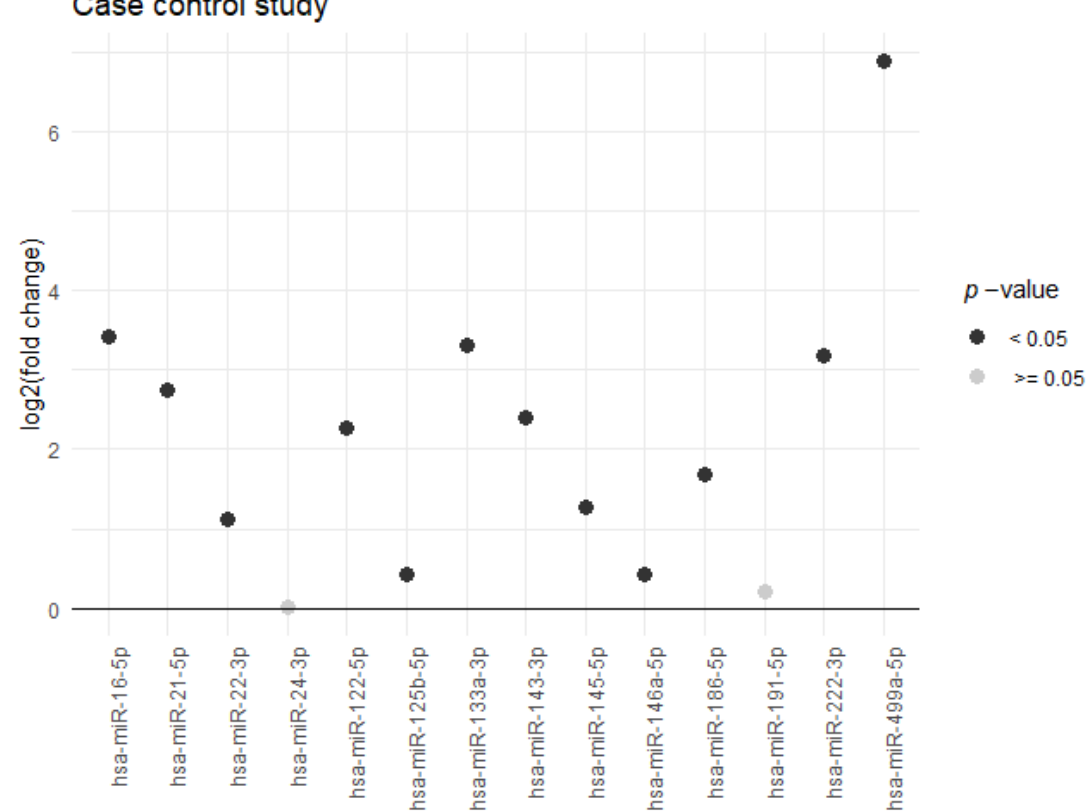
Figure 2. Di ff erentially expressed miRNAs in acute myocardial infarction cases compared to controls. miRNA expression was measured in serum samples of 476 acute myocardial infarction cases and 487 controls, matched by age and sex, using custom OpenArray plates by qPCR. The 14 miRNAs analyzed, with < 90% of missing values, are presented. Di ff erential expression of miRNAs was examined with the fold change and log rank test using global normalization. p -values were adjusted for multiple comparisons. Expression values are presented in Table S7. Log2 (fold change): binary logarithm of the fold change.